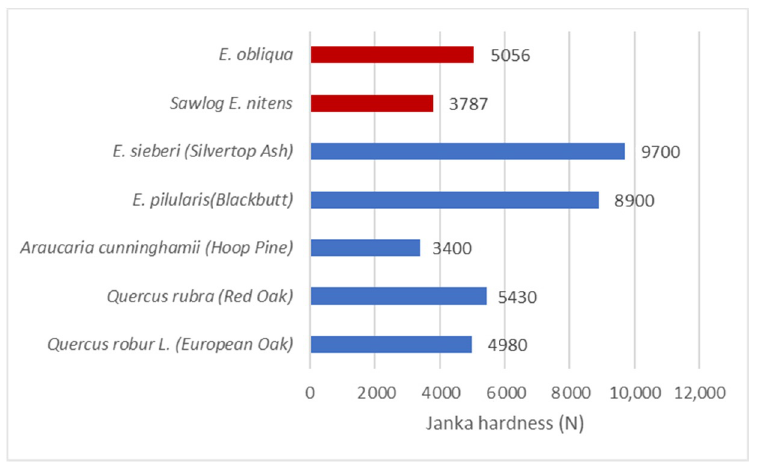
Figure 10. Comparing Janka hardness of studied species with commonly used flooring species .